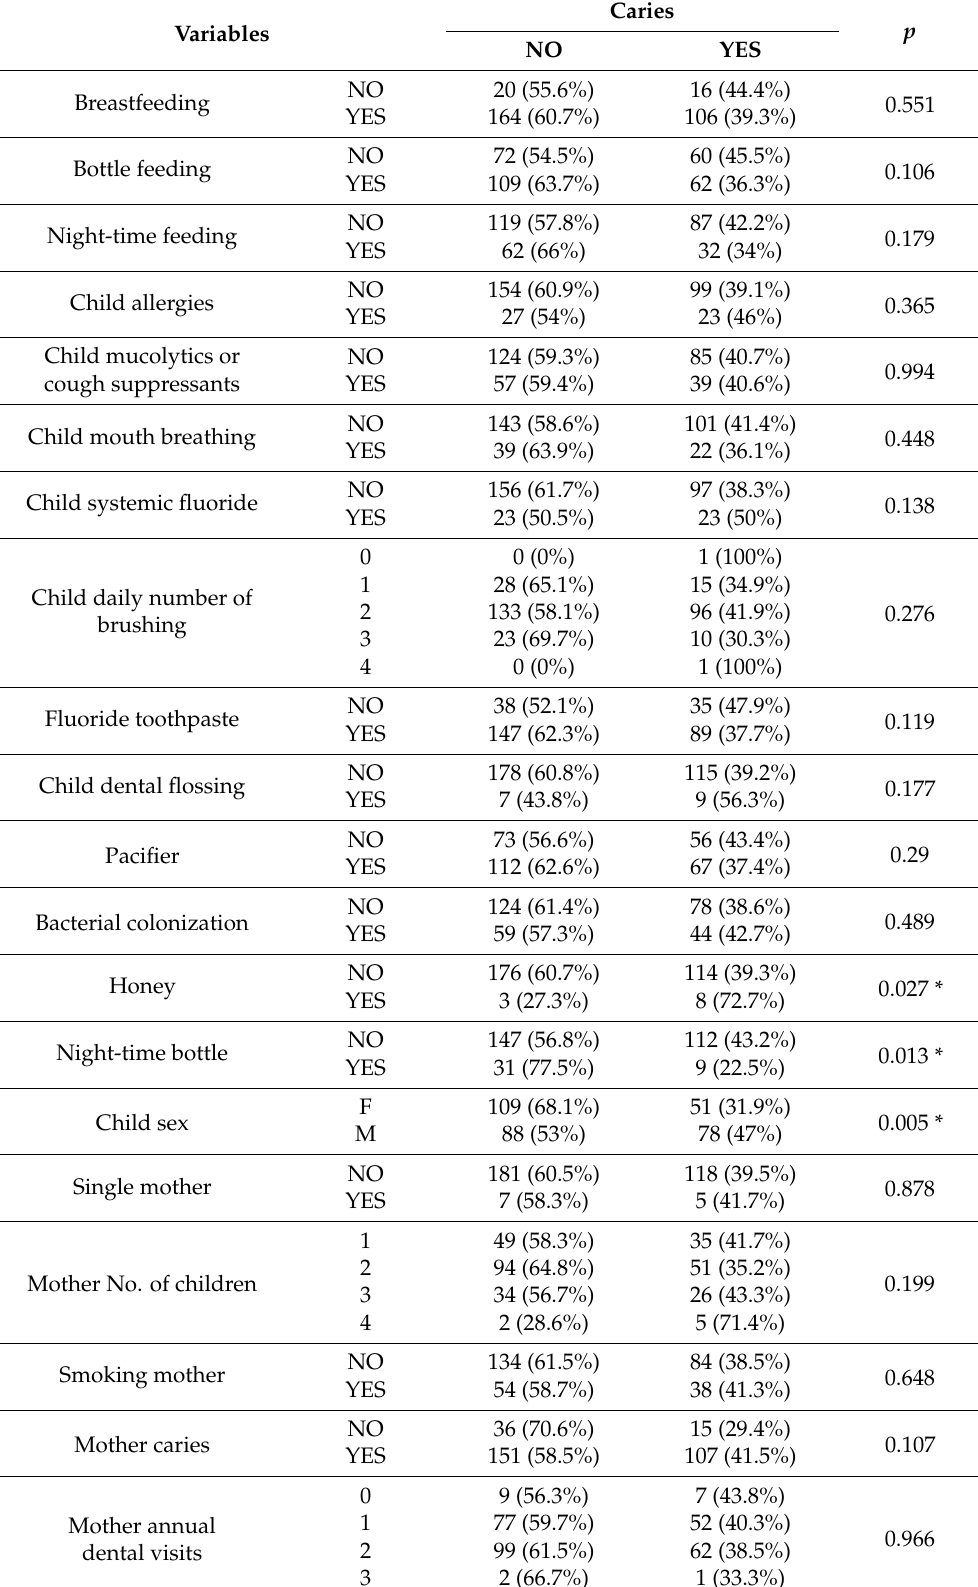
Table 1. Presence of caries compared with the variables analyzed and p value.